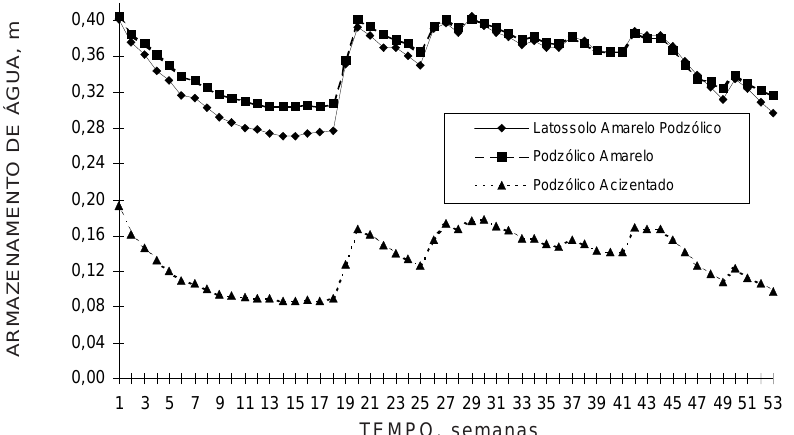
Figura 2. Armazenamento de água até a profundidade de 1,50 m, durante o período de um ano, a partir de 18 de dezembro de 1995, em uma toposseqüência de solos de tabuleiro cultivados com citros, no município de Sapeaçu